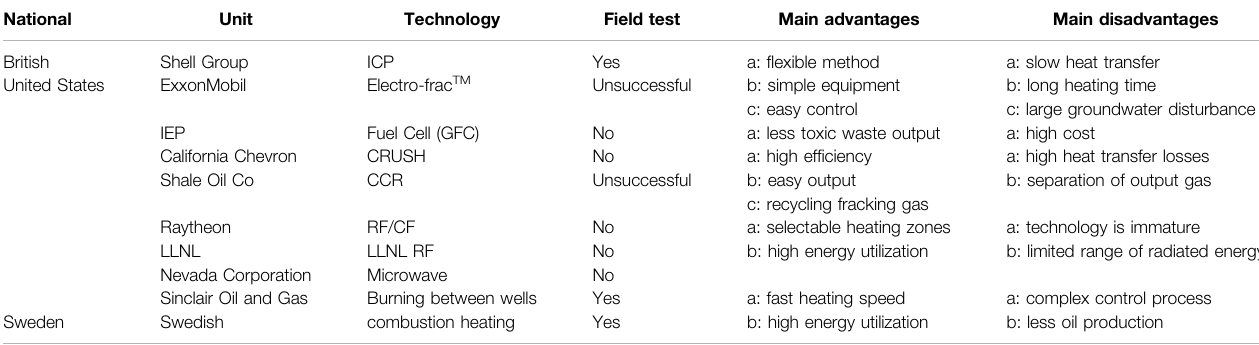
TABLE 1 | International comparison of fi eld heating technologies. National Unit Technology